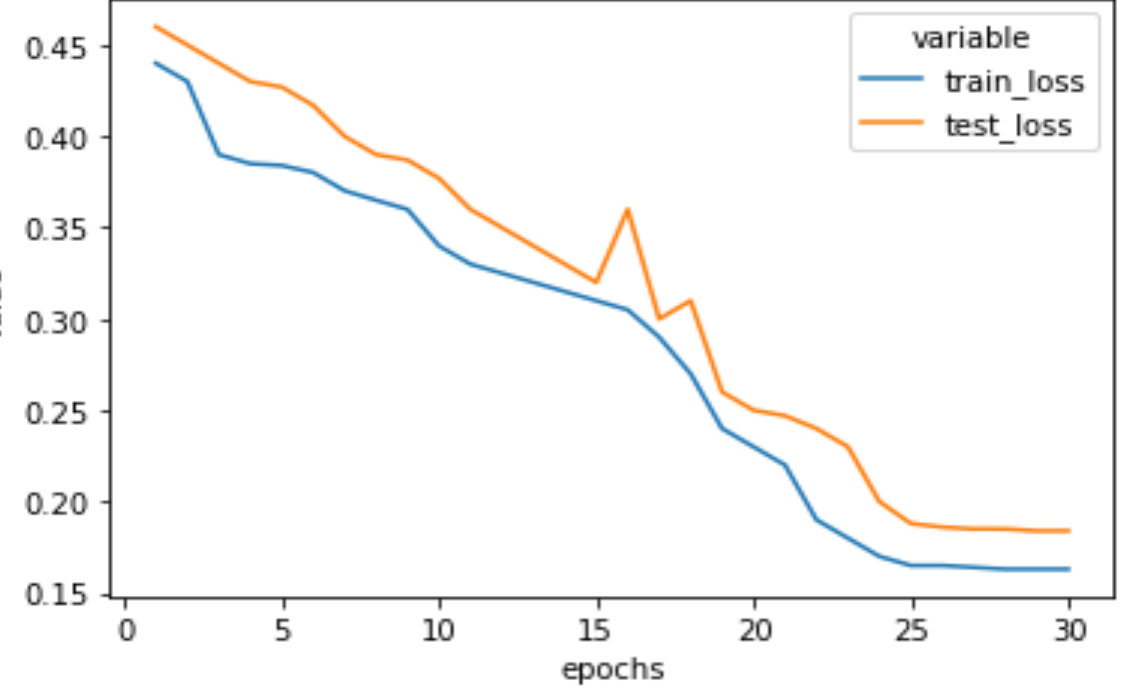
Figure 10. Testing loss and training loss of our proposed model on the augmented dataset.